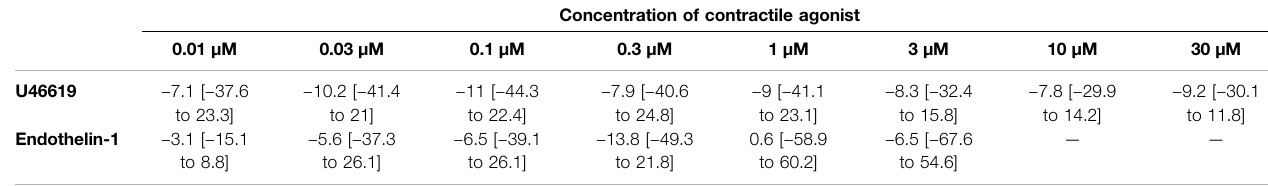
Data are based on experiments on series with n (cid:1) 5 prostates for each mirabegron concentration and corresponding controls, i. e. 10 prostates in total.